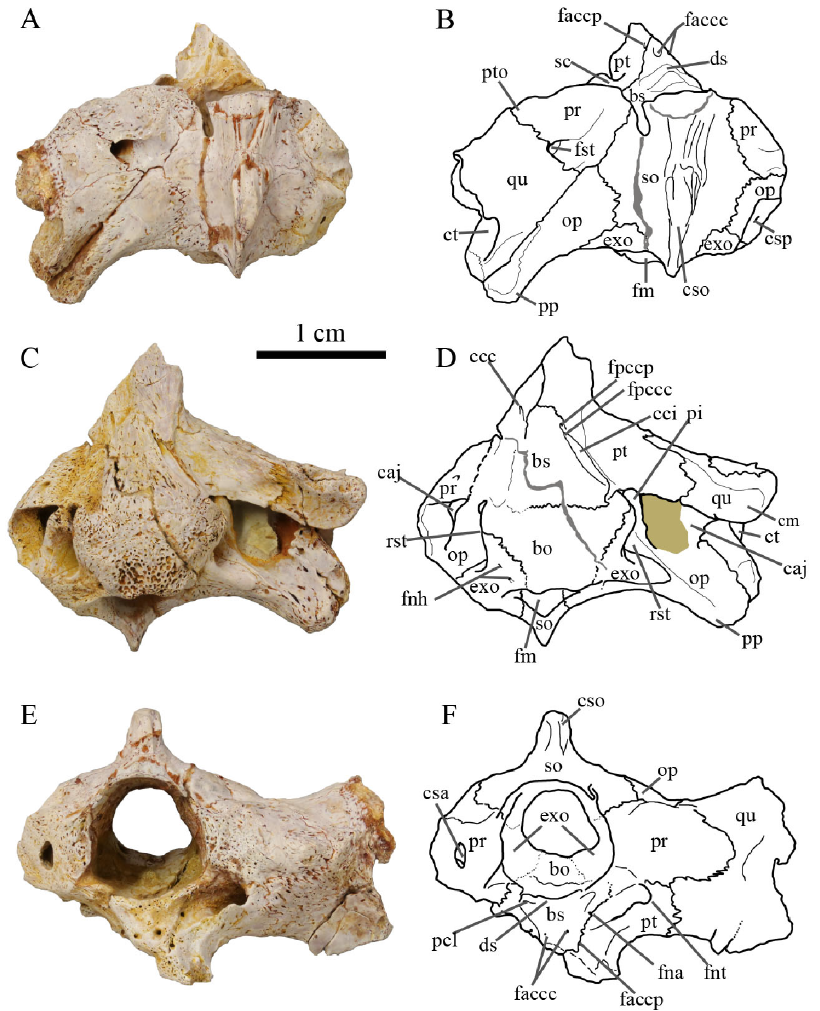
Fig 3. Basicranium MJSN CBE-0002. Photographs and interpretative drawings in dorsal view (A-B), in ventral view (C-D) and in anterior view (E-F). Abbreviations: bo, basioccipital; bs, basisphenoid; caj, cavum acustico-jugulare; ccc, canalis caroticus cerebralis; cci, canalis caroticus internus; cm, condylus mandibularis; csa, canalis semicircularis anterior; cso, crista supraoccipitalis; csp, canalis semicircularis posterior; ct, cavum tympani; ds, dorsum sellae; exo, exoccipital; faccc, foramen anterius canalis carotici cerebralis; faccp, foramen anterius canalis carotici palatinum; fm, foramen magnum; fna, foramen nervi abducentis; fnh, foramen nervi hypoglossi; fnt, foramen nervi trigemini; fpccc, formamen posterius canalis carotici cerebralis; fpccp, foramen posterius canalis carotici palatinum; fst, foramen stapedio-temporale; op, opisthotic; pcl, processus clinoideus; pi, processus interfenestralis; pp, processus paroccipitalis; pr, prootic; pt, pterygoid; pto, processus trochlearis oticum; qu, quadrate; rst, recessus scalae tympani; sc, sulcus cavernosus; so, supraoccipital. The prootic is too poorly preserved to conclude on the presence or absence of an ossified pila prootica (an autapomorphy of Plesiochelys etalloni ; [12,24]). On the dorsal surface of the otic chamber, there is a broad contact between the prootic and opisthotic, which prevents a contact between the supraoccipital and quadrate. This differs from most specimens referred to Plesiochelys etalloni [11]. As in the type material of Plesiochelys bigleri , the processus paroccipi- talis extends posterolaterally. The foramen externum nervi glossopharyngei is also located quite laterally at the base of the processus interfenestralis. Due to the presence of matrix in this area, it is difficult to confirm the presence of a ridge extending anteriorly from the base of the